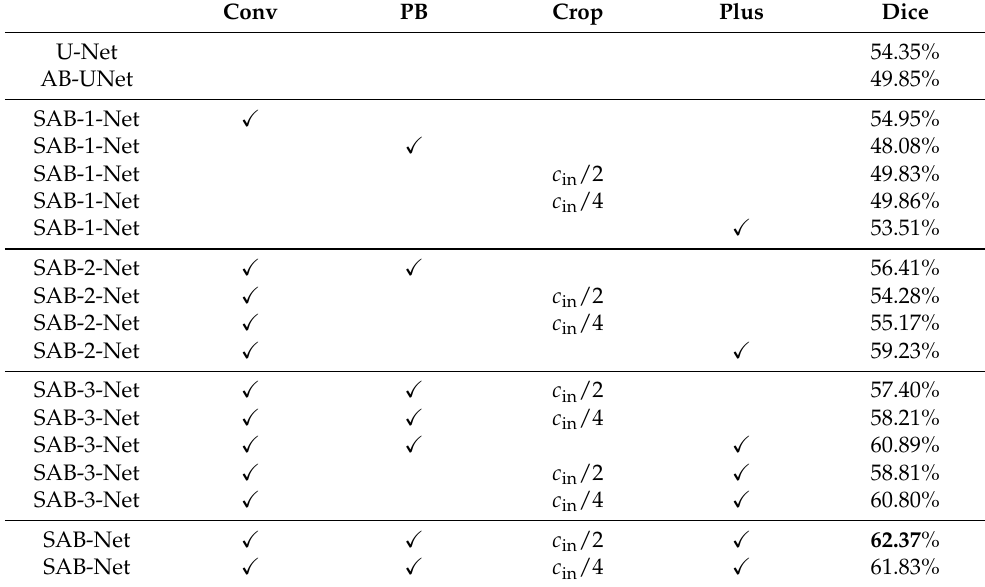
Table 1. Ablation study conducted on the Brain MRI test set. Conv denotes convolutions within SABs, PB denotes position blurring, Crop denotes inner cropping, and Plus denotes the redesigned skip pathway. SAB-1, 2, and 3 denote the methods employing one, two, and three of the proposed operations.